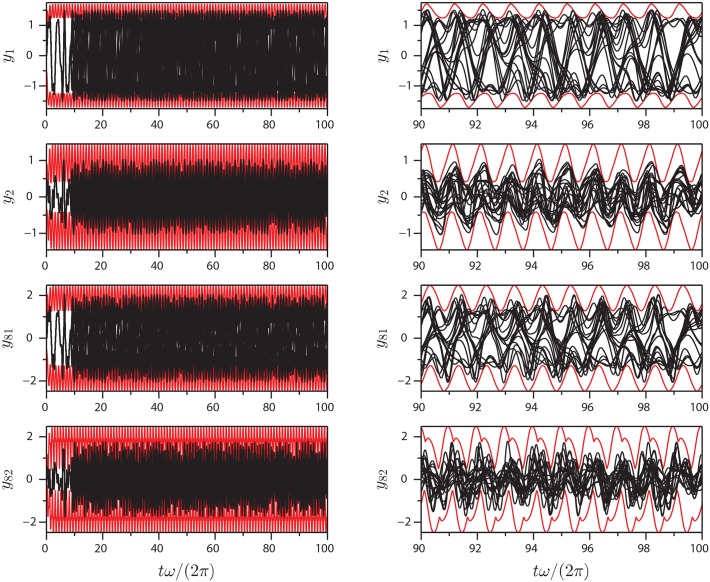
Extrema of Eq (12): Plots of extrema (red) and 20 different time series (black) of variables y1, y2, y81 and y82 for parameter set III.